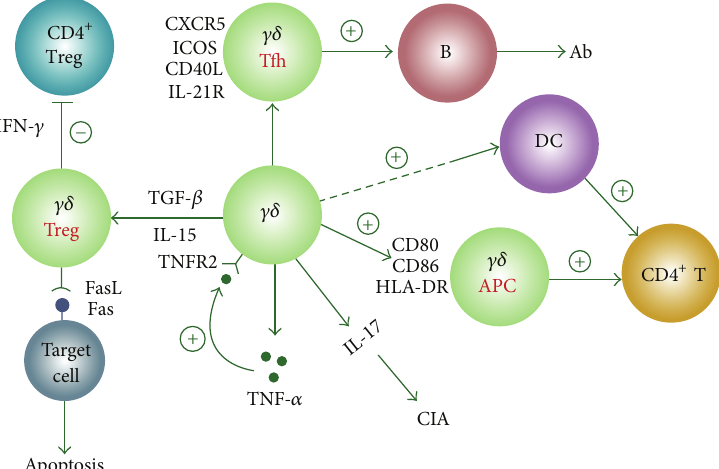
Figure 1: Roles of 𝛾𝛿 T cells in autoimmune diseases. Ab: antibody, APC: antigen presenting cell, CIA: collagen-induced arthritis, DC: dendritic cell, Tfh: B helper T cell, TNFR2: TNF- 𝛼 receptor 2.